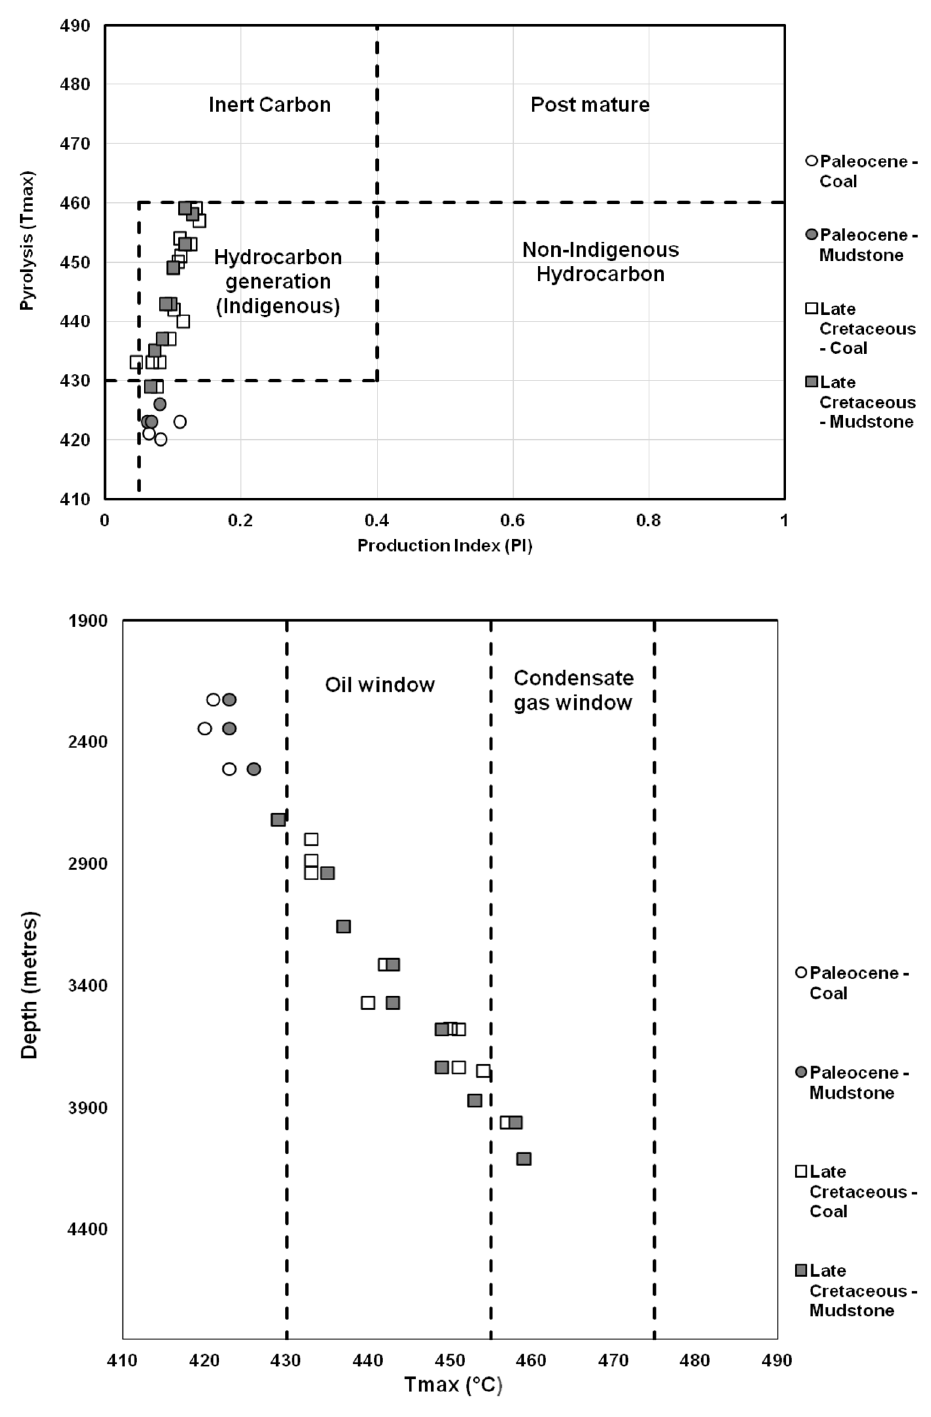
Fig. 9 A cross-plot of maximum pyrolysis temperature ( T max ) versus production index (PI) to identify source rock maturity